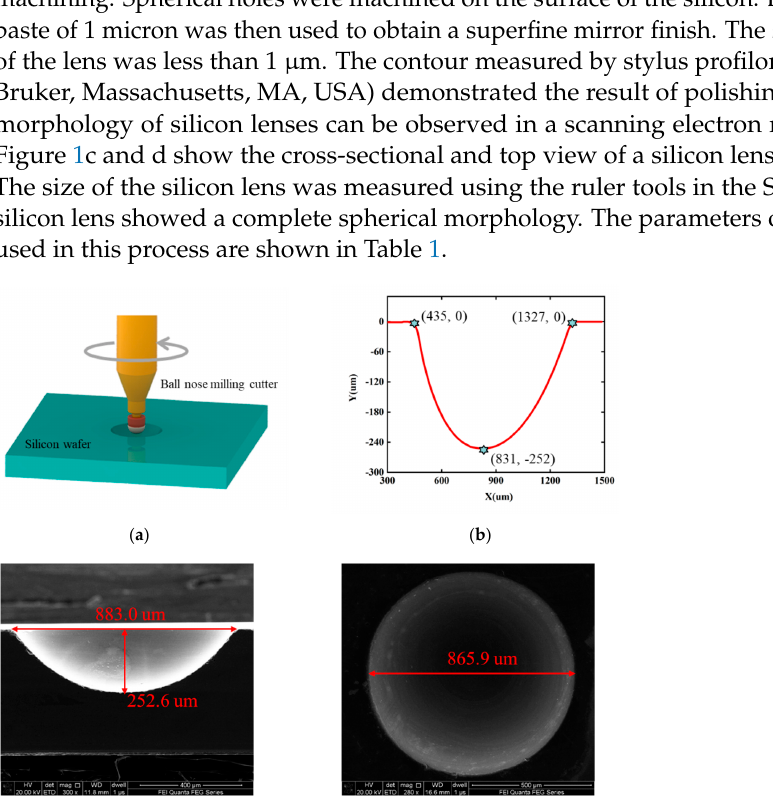
Figure 1. ( a ) Spherical holes machining. ( b ) Contour of the silicon lens measured by stylus profilometer. ( c ) A cross-sectional view of the silicon lens imaged by SEM. ( d ) A top view of the silicon lens imaged by SEM.